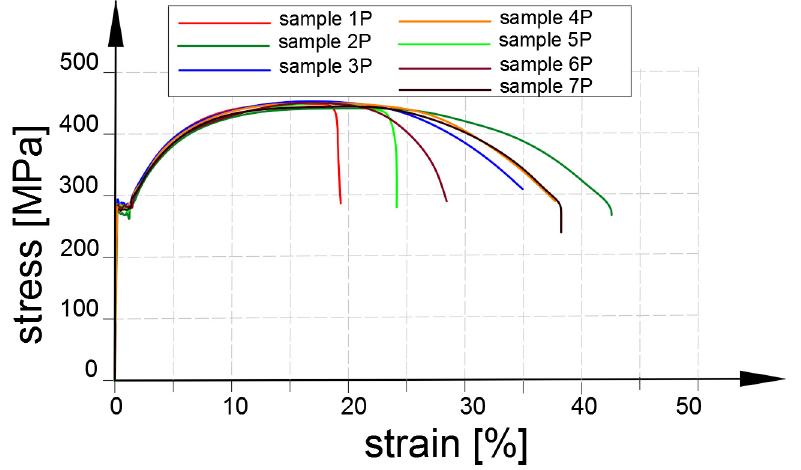
Figure A2. Engineering stress–strain curves for 16Mo3 + N alloy steel. Samples were cut from flat end in transversal direction (set 1b).